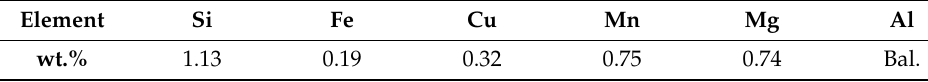
Figure 1. Schematic presentation of laboratory melt preparation routes. Table 1. Chemical composition of the alloy.